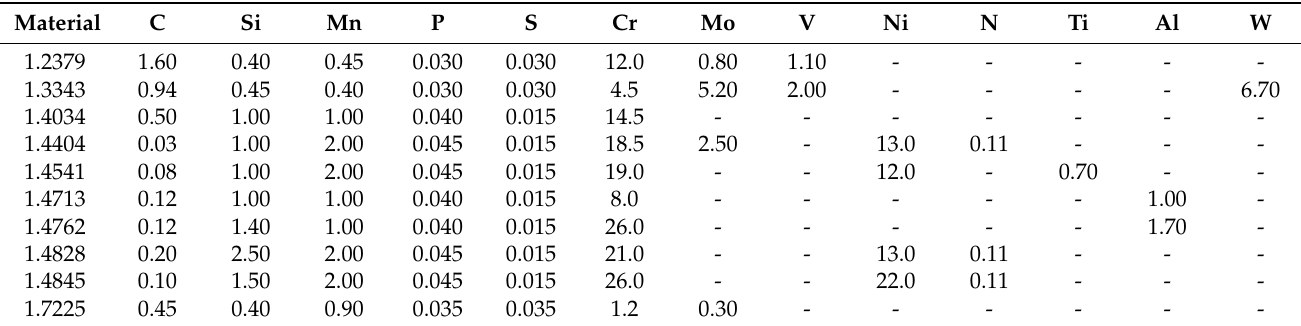
Table 5. Maximal elemental composition (mass percentage) selected for used steels from lexicon of steels